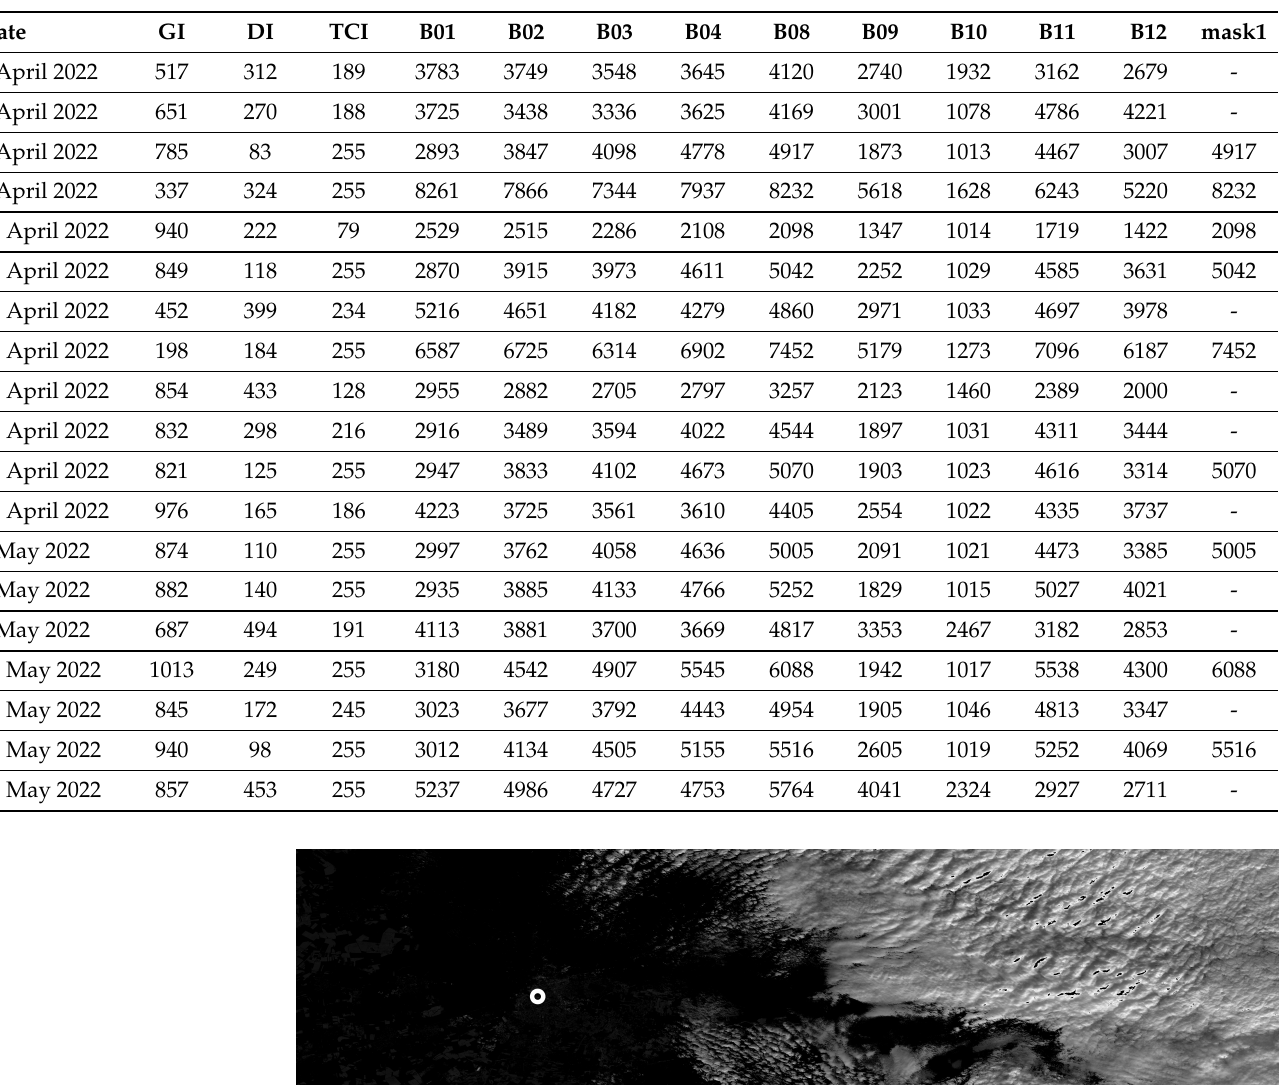
Table 3. Examples of retrieved pixel values for different bands and cloud type values. mask1 stands for allCloudMask . GI and DI unit: W/m 2 .